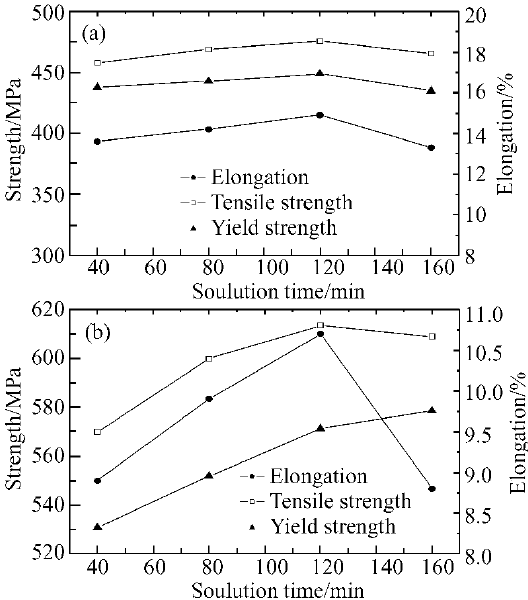
Figure 11. Change of tensile properties of studied alloy with solution time at 470 °C ( a ) solution ( b ) solution+T6. Adapted with permission from ref. [64]. 2007 Dai et al.